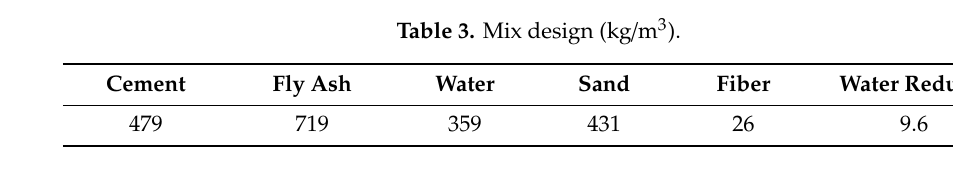
Table 4. Properties of epoxy binder.